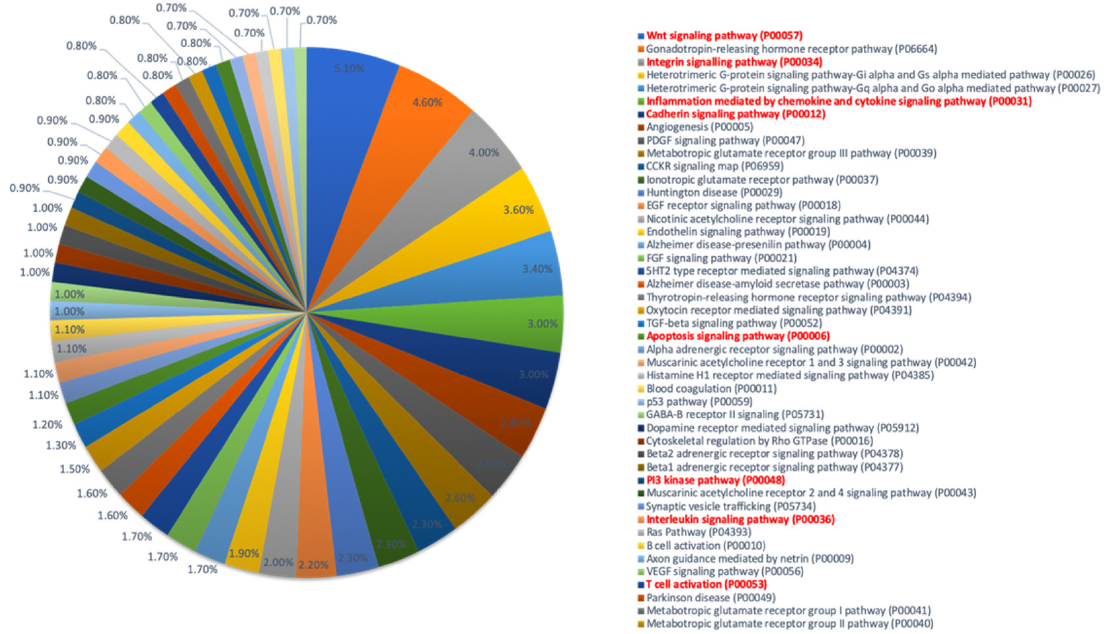
Figure 6. Gene Ontology pathway enrichment analysis in co-infected A3R5.7 cells. List of pathways downregulated in A3R5.7 cells infected with HSV-2 and HIV-1 based on gene enrichment analysis with a p < 0.05 and FDR < 0.05.